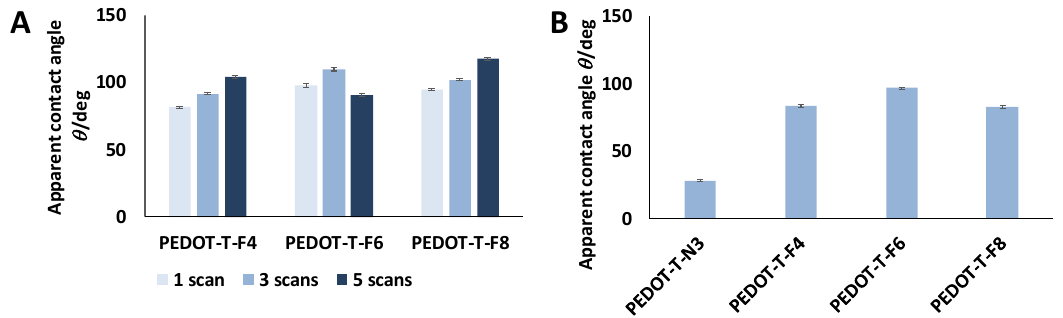
Figure 6. Apparent contact angle with diiodomethane measured for surfaces developed with ante strategy ( A ) and post strategy ( B ). The bars on the columns illustrate the standard deviations of the measurements.